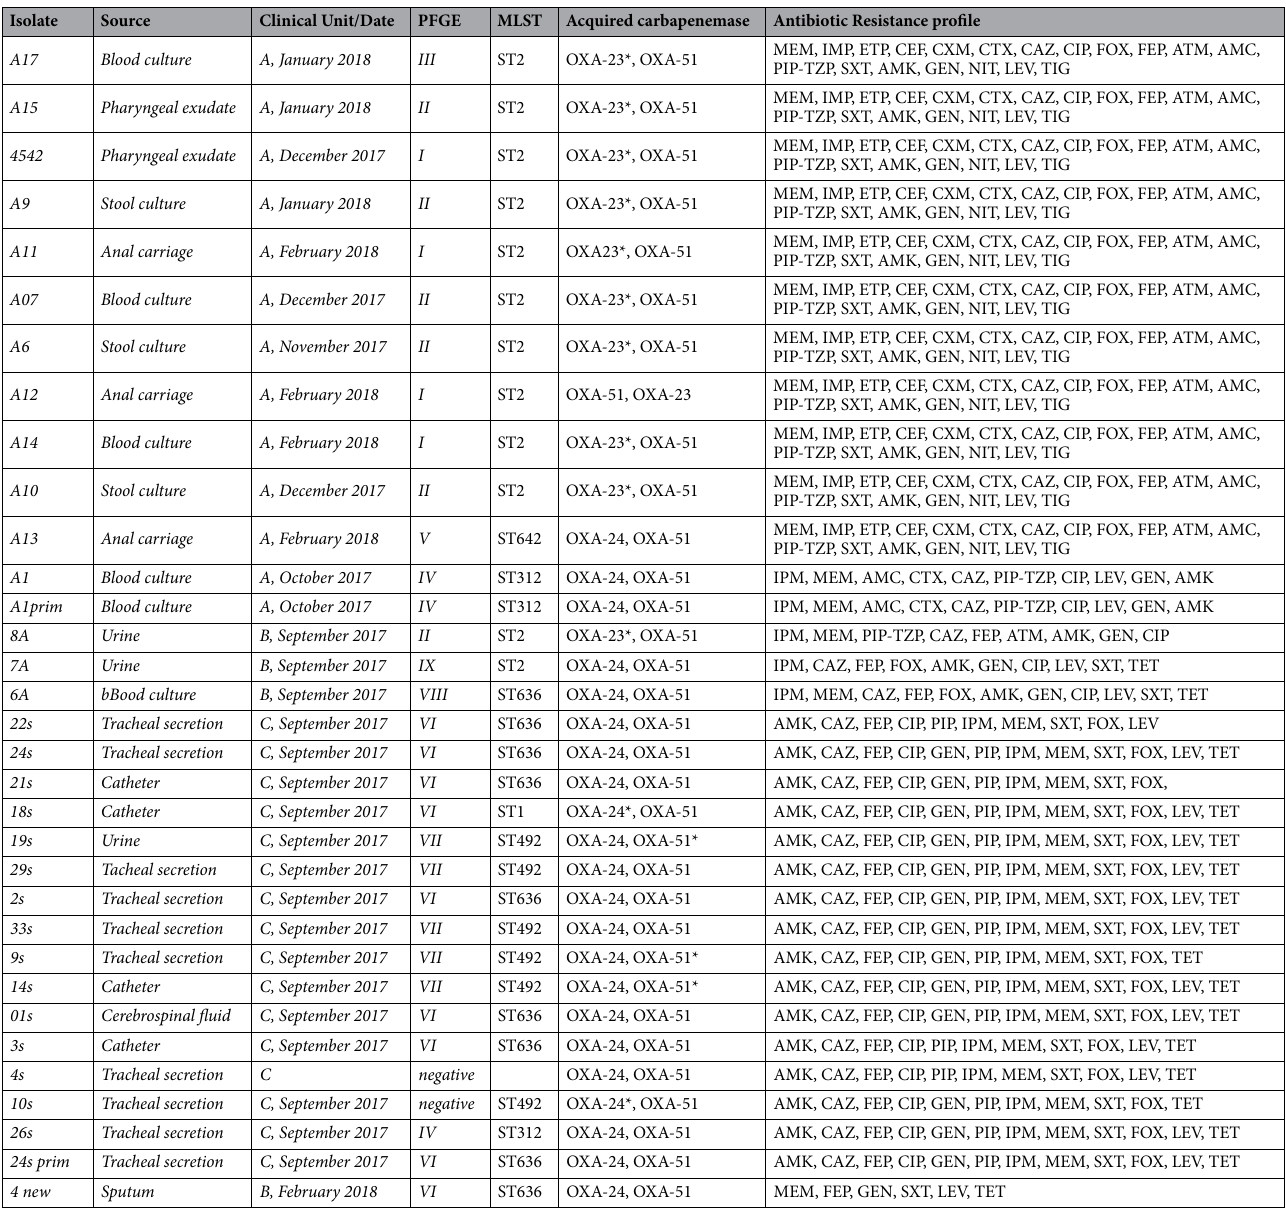
Table 1. Clinical specimen, carbapenemase, PFGE-type and MLST results, for A. baumannii clinical isolates from Romania. 1 Notes: A = ICU ; B- Ambulatory; C- Children Hospital. (*) indicates the IS Aba1 insertion upstream of the gene encoding respective carbapenemase. MEM = meropenem, IPM = imipenem, ETP = ertapenem, CEF = cephalotin, CTX = ceftriaxone, CXM = cefuroxime, FOX =